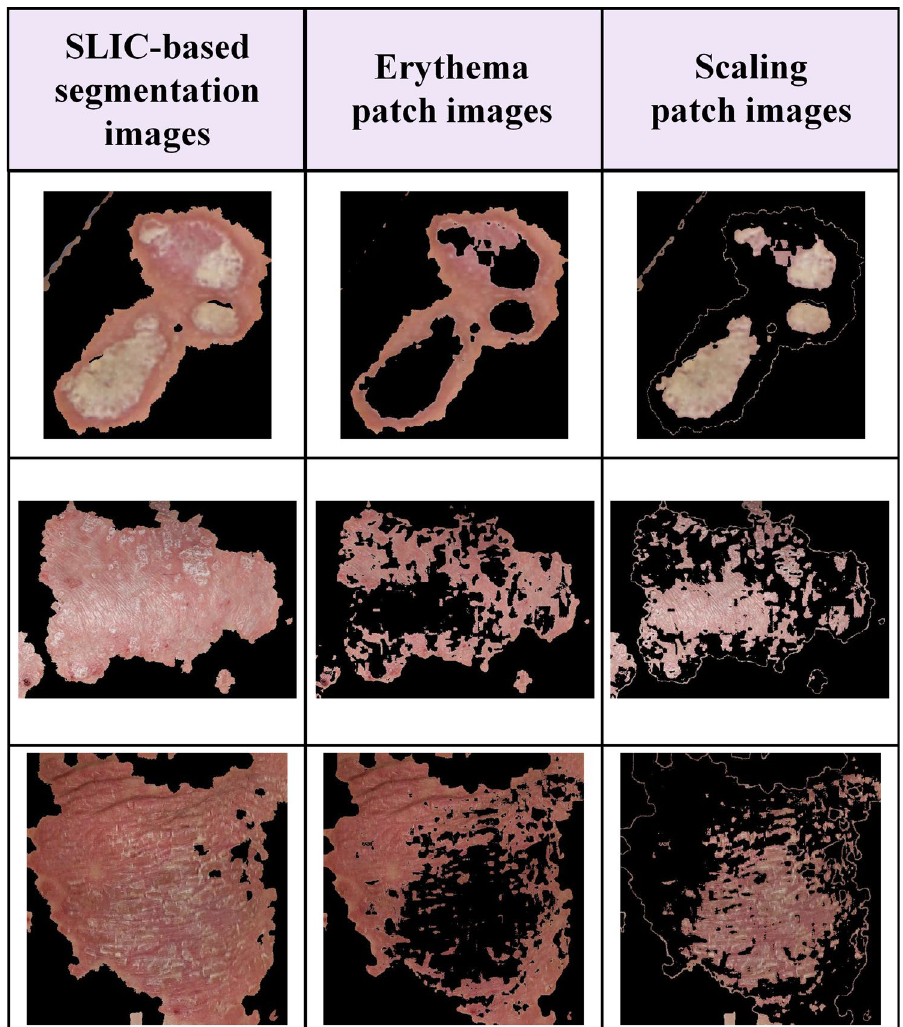
and patch images for erythema and scaling that coincide with